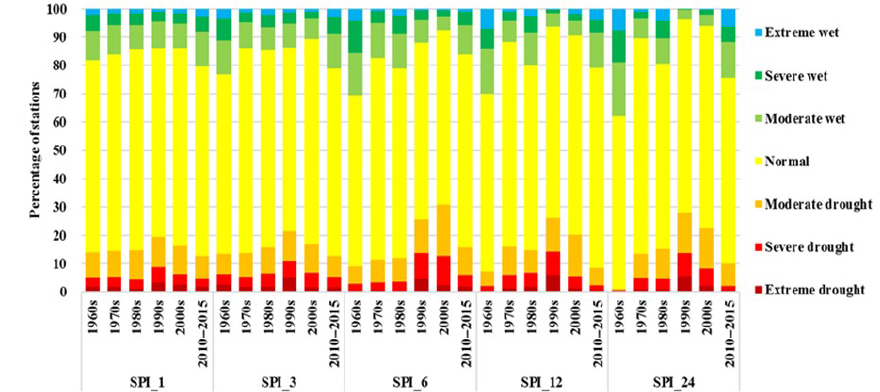
Figure 3. Drought frequency in different decades at different time scales in the Wei River Basin.